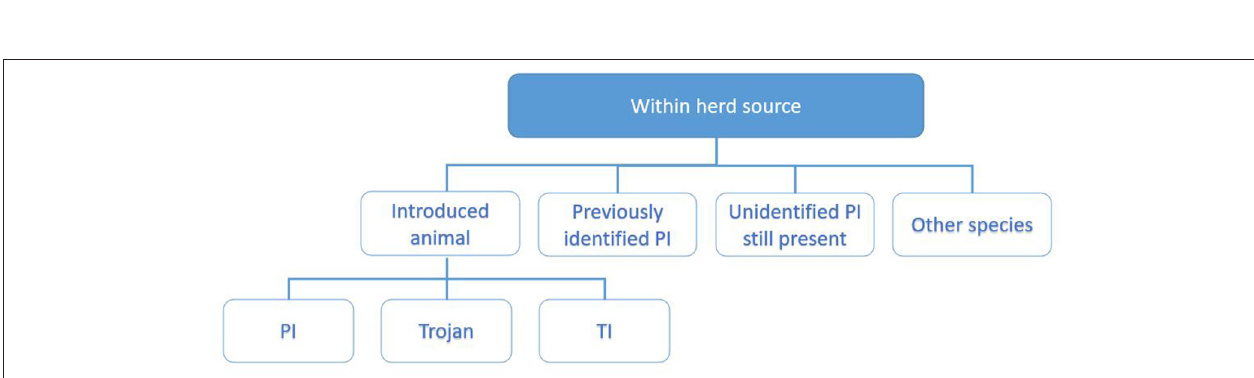
FIGURE 3 | Categorisation of potential within-herd sources of infection explored during the investigation. These include introduced animals (9, 15, 16), previously identified PI (17), unidentified PI still present (14), and other species (18, 19).